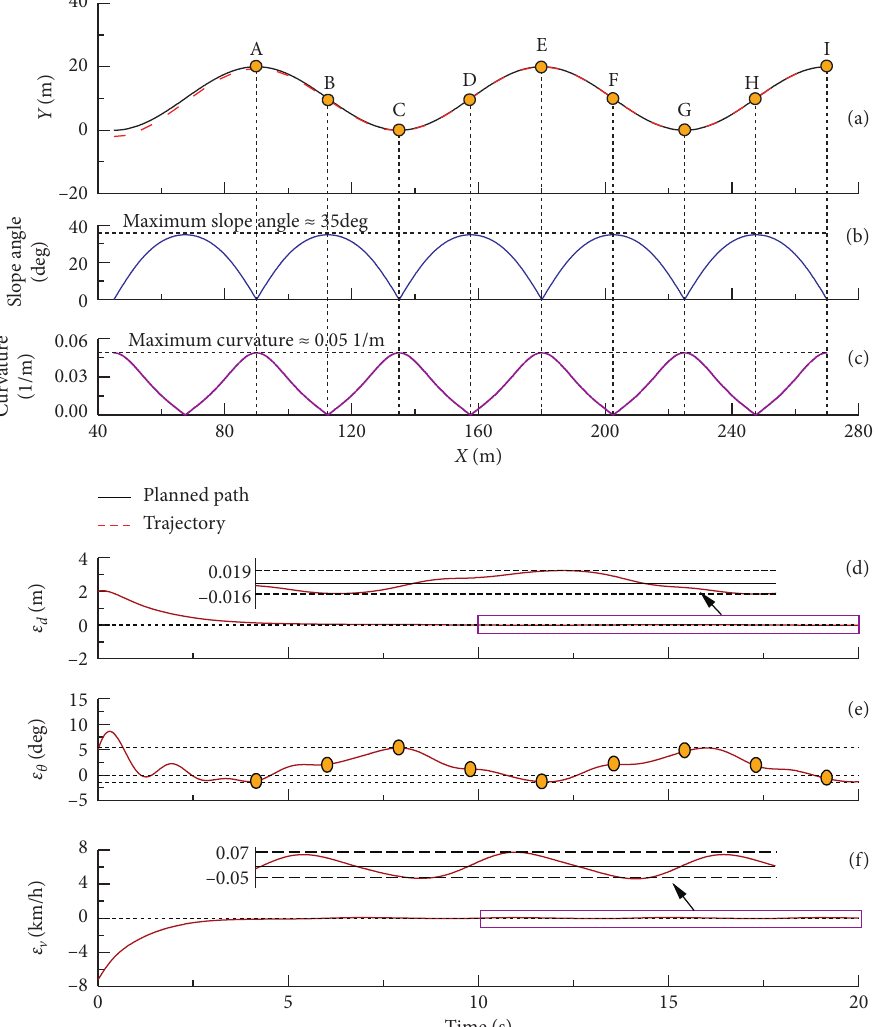
Figure 16: The control performances of the vehicle in the sinusoidal path-following